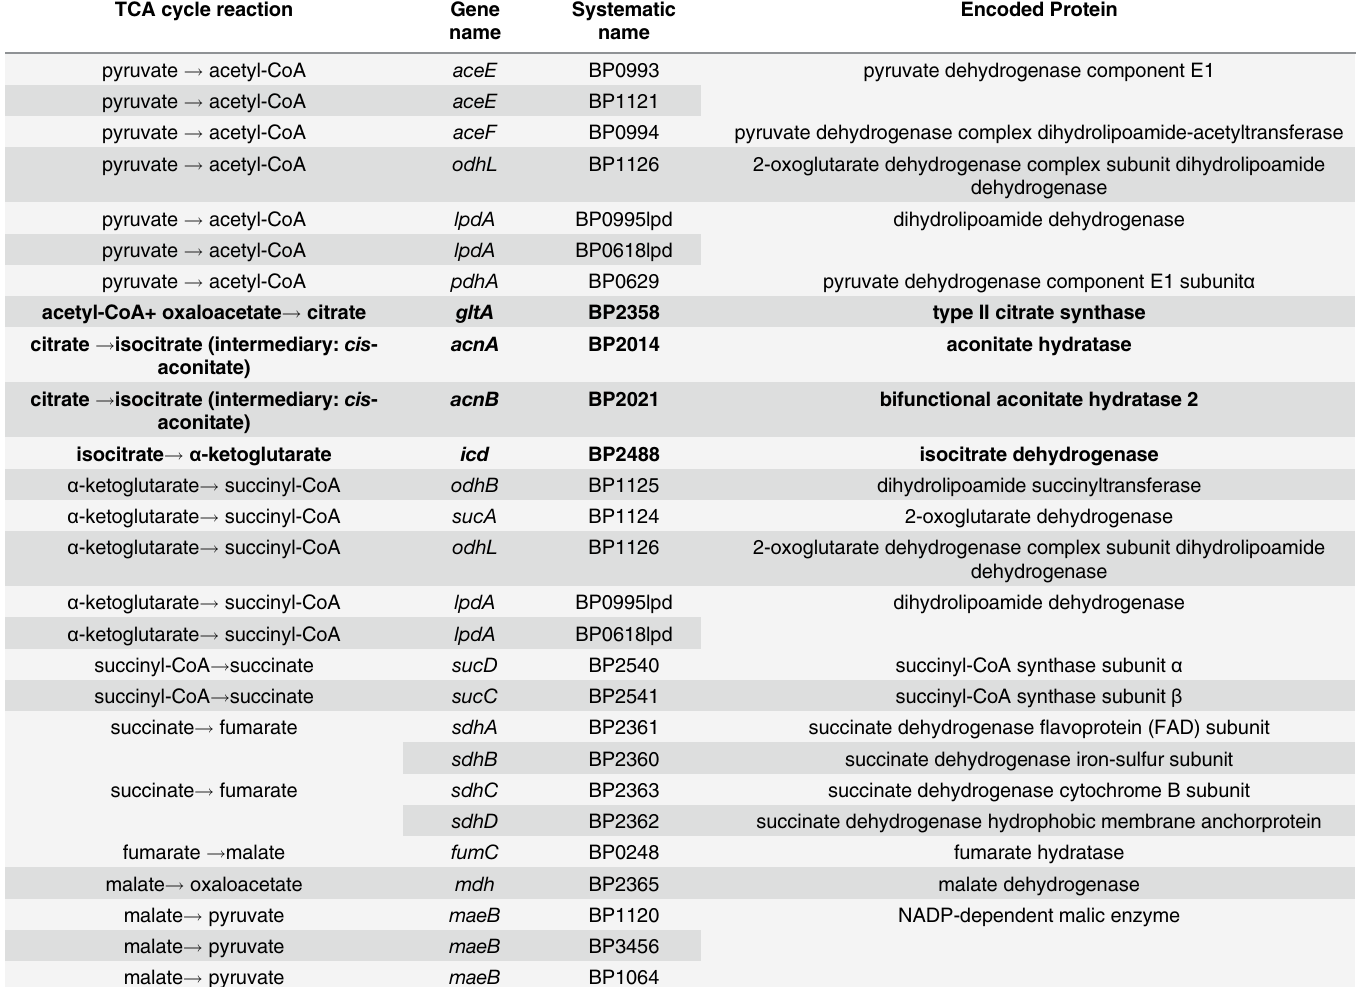
Table 3. Genes encoding Tricarboxicilic Acid Cycle enzymes in the B . pertussis Tohama I